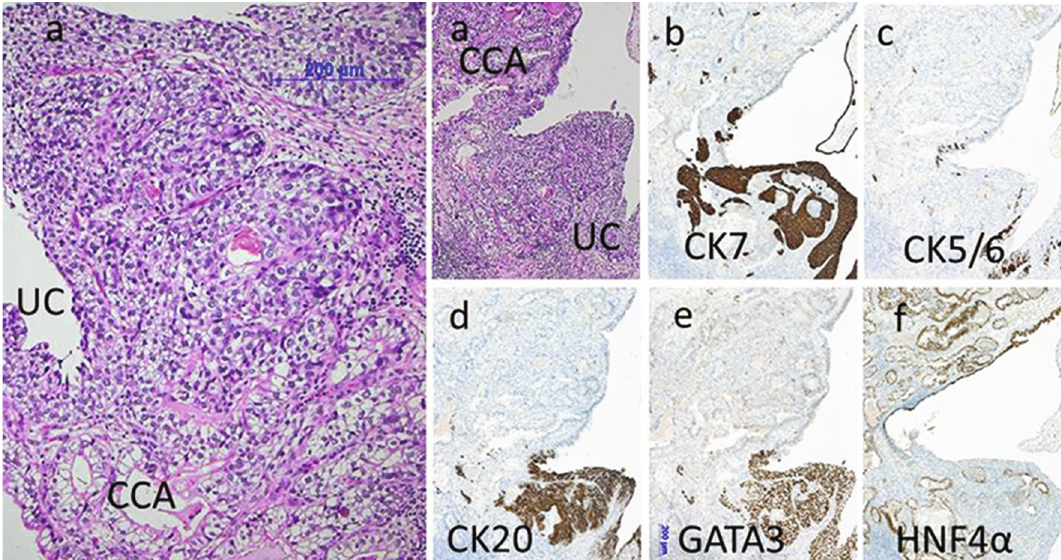
Figure 2: Pathological fi ndings. Histopathological fi ndings reveal that urothelial carcinoma in situ ((a) UC) persisted in part; however, most of the tumor is clear cell adenocarcinoma ((a) CCA) ((a) hematoxylin and eosin). The clear cell adenocarcinoma lesion has clear cytoplasm with round nuclei and visible nucleoli in an insular arrangement. No transitional lesion between clear cell adenocarcinoma and urothelial carcinoma can be presented in this lesion. The clear cell adenocarcinoma lesion is CK7 negative (b), CK5/6 negative (c), CK20 negative (d), GATA3 negative (e), and HNF4 α positive (f). The urothelial cancer lesion is CK7 positive (b), CK5/6 weak positive (c), CK20 positive (d), GATA3 positive (e), and HNF4 α negative (f). CCA: clear cell adenocarcinoma; UC: urothelial